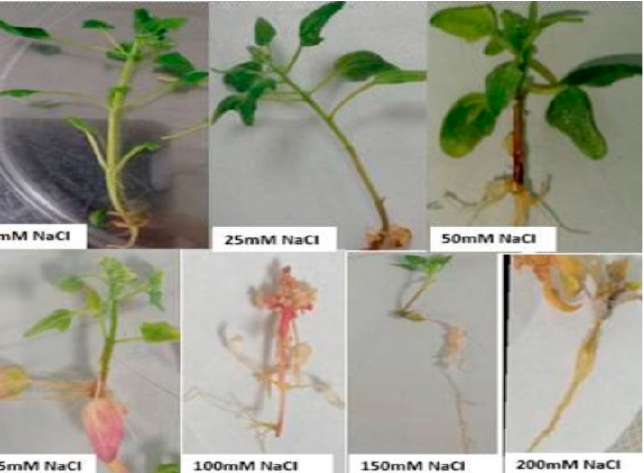
Figure 1. In vitro growth parameters of Q6 quinoa plantlets under the effect of (0–200) mM NaCl. Bar represents 0.5 cm. Table 1. Effect of different NaCl levels on shoot length (SL), leaf number (LN), fresh weight (FW), and Dry weight (DW) for Q6 quinoa